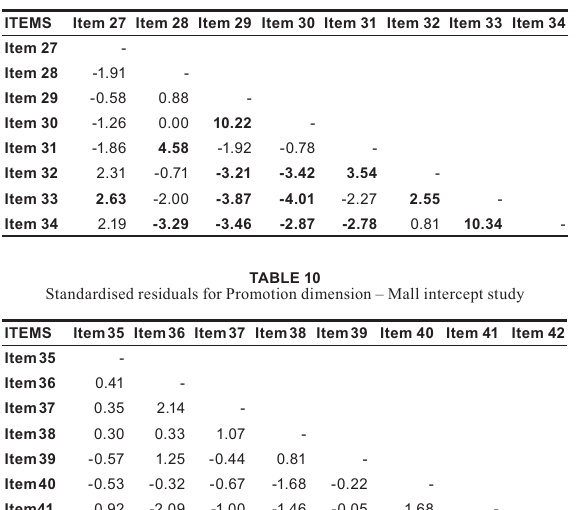
TABLE 6 Standardised residuals for Convenience dimension – Mall intercept study